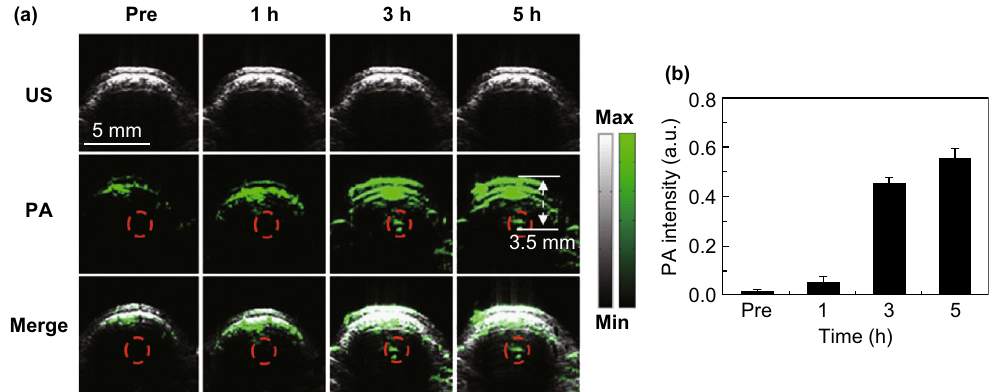
Fig. 5 a B-scan ultrasound (US), photoacoustic (PA), and their merged images of the brain tumor region before and at 1, 3, and 5 h after intravenous injection of MoS 2 –ICG. The ultrasound images were used to delineate the scalp and skull of the mouse. The photoacoustic signals in the red circles show the accumulation and distribution of MoS 2 –ICG within the brain glioma. b Quantification results of photoacoustic signals in the tumor region at different time points before and after MoS 2 –ICG injection